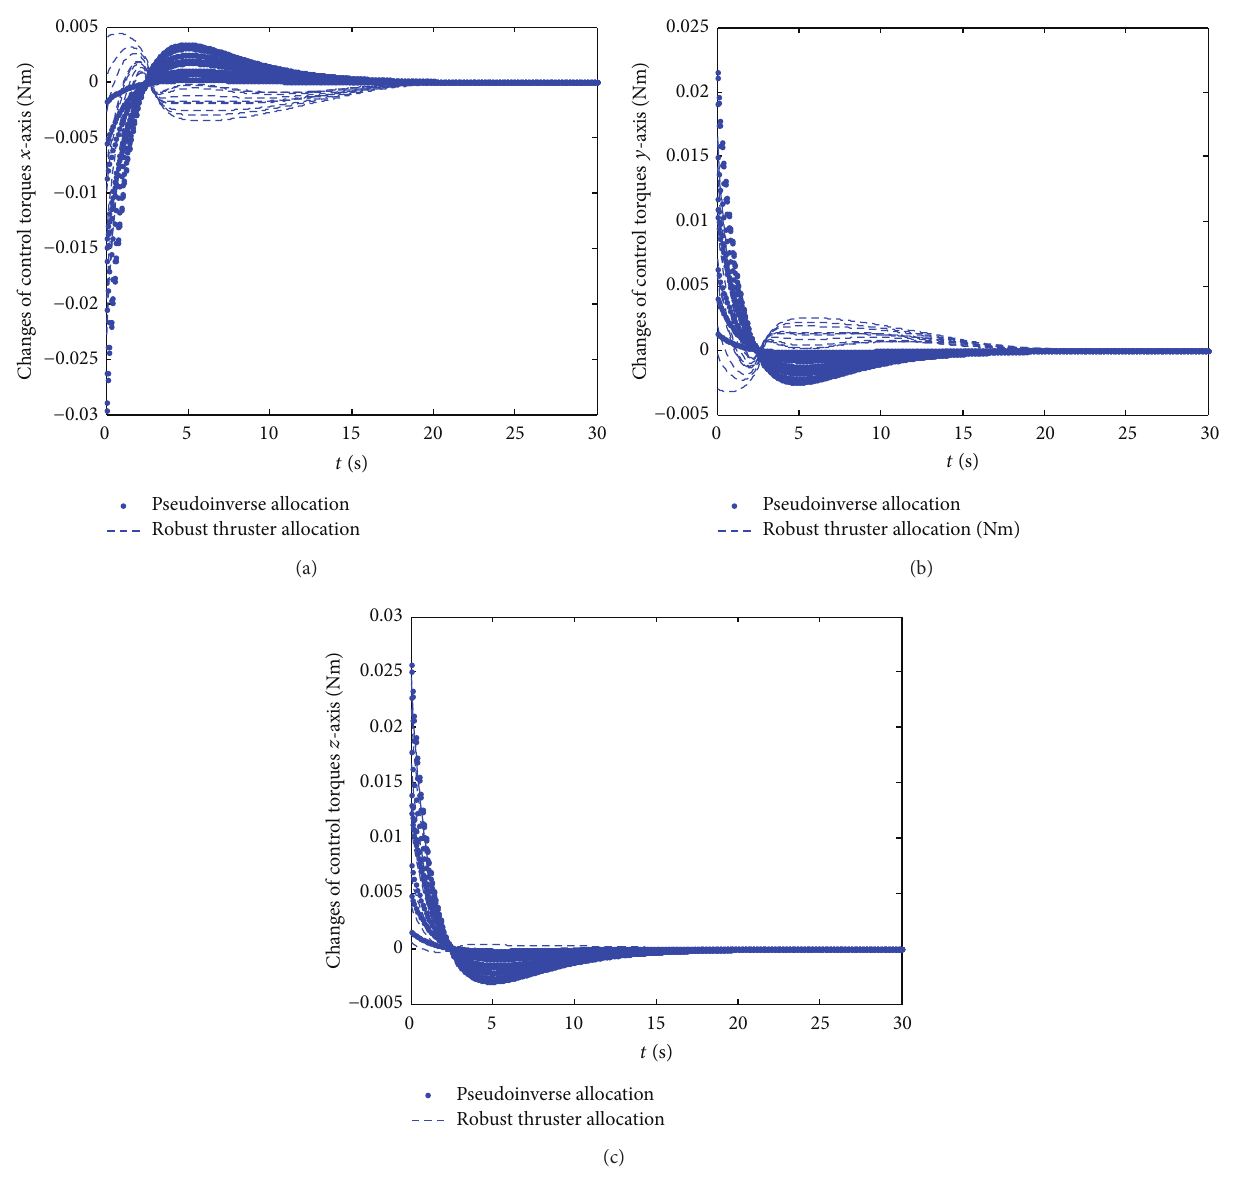
Figure 5: The curves of torque distribution deviation when the control efficiency matrix is with the uncertainty of 20%.